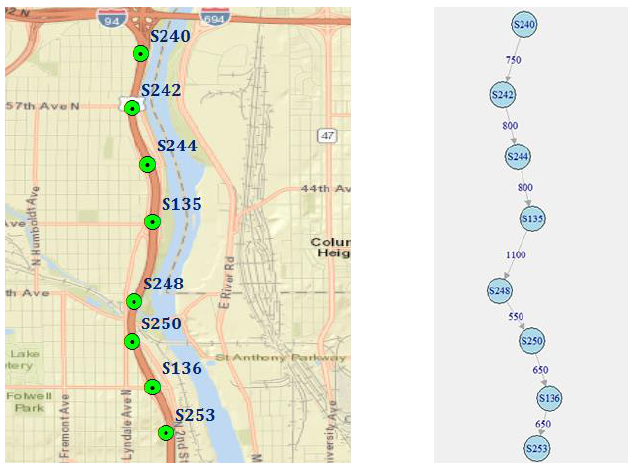
Figure 1. Road segment with sequential sensor locations: a map and corresponding weighted directed graph (weights represent distances by road in meters).